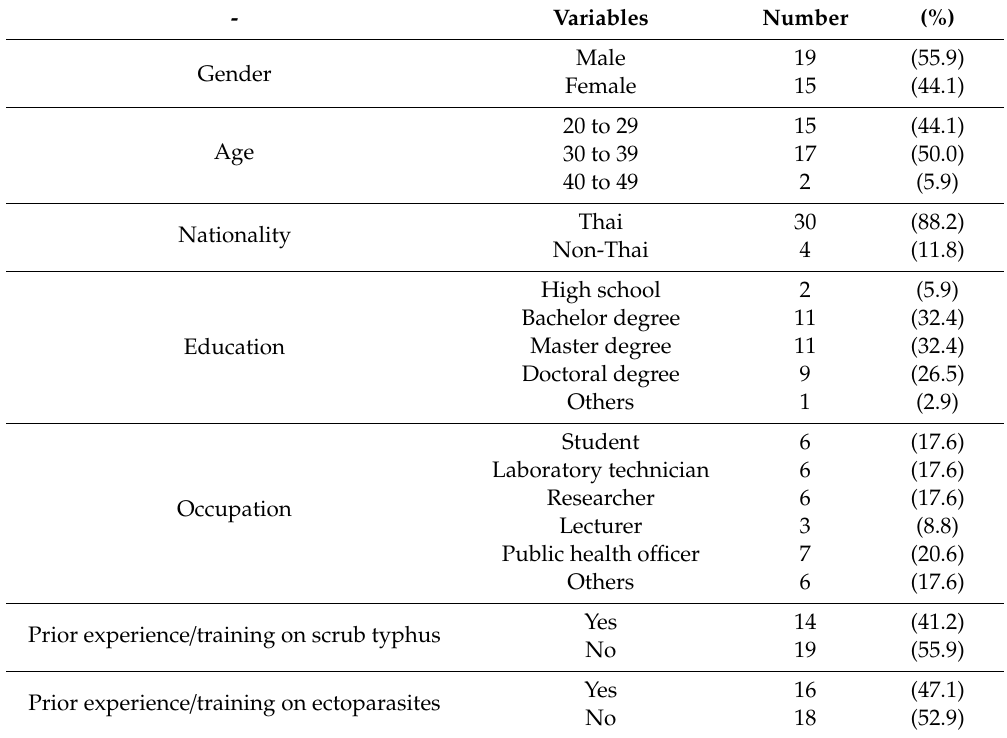
Table 1. Demographic data of study